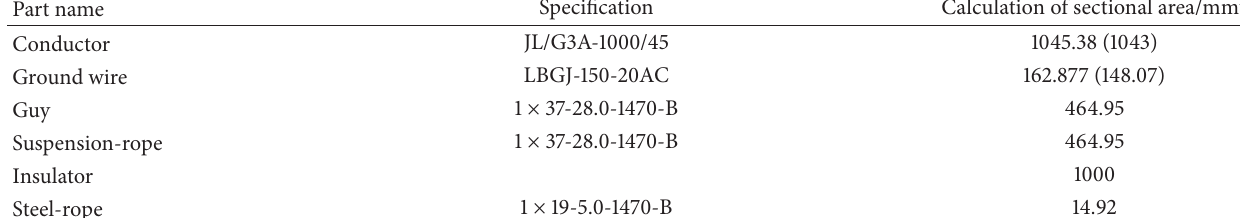
Table 2: The parameter of cross-rope suspension tower-line.